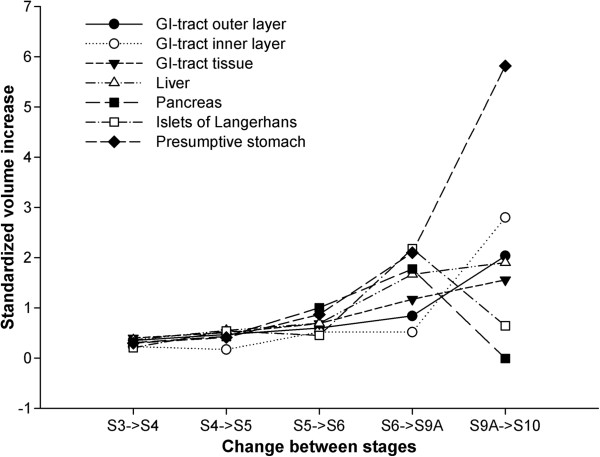
Standardized volume increase of digestive organs between stage (S) 3 to 10 of Atlantic halibut. The volume increase was normalized to the overall mean of volume increase between stages for each tissue (for detailed explanation, see Additional file 2).